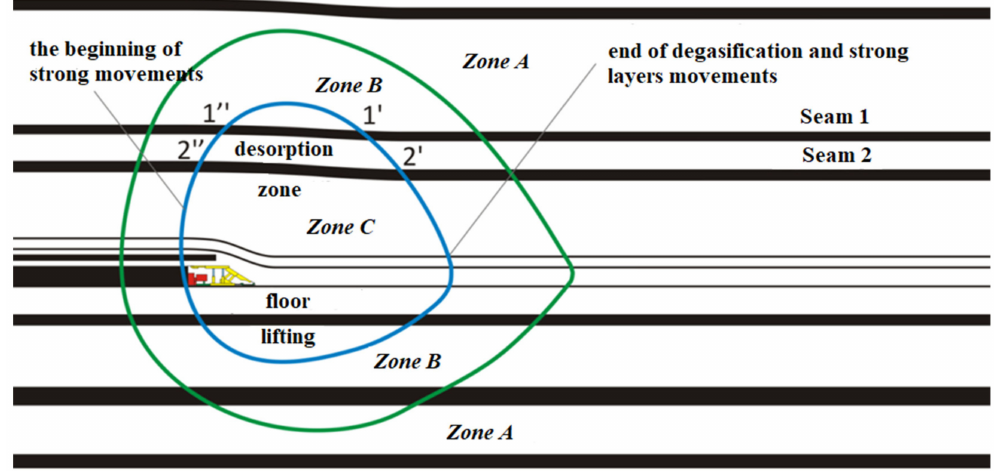
Figure 5. The influence of exploitation on the degasification of adjacent layers (adapted from